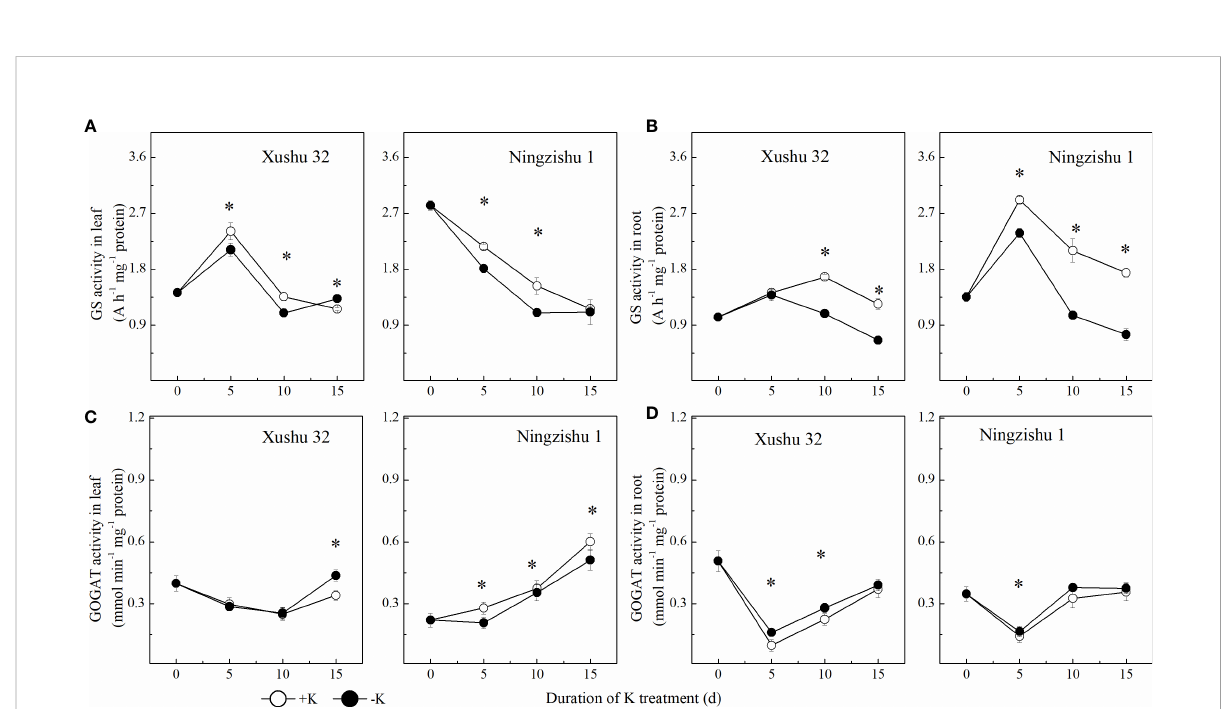
FIGURE 8 Changes of GS and GOGAT activities in leaves and roots for two K treatments for Xushu 32 and Ningzishu 1. (A, B) leaf and root GS activities. (C, D) Leaf and root GOGAT activities. The stages labeled with an asterisk (*) indicate signi fi cant differences ( p < 0.05) between − K and +K. GS, glutamine synthetase; GOGAT, glutamate